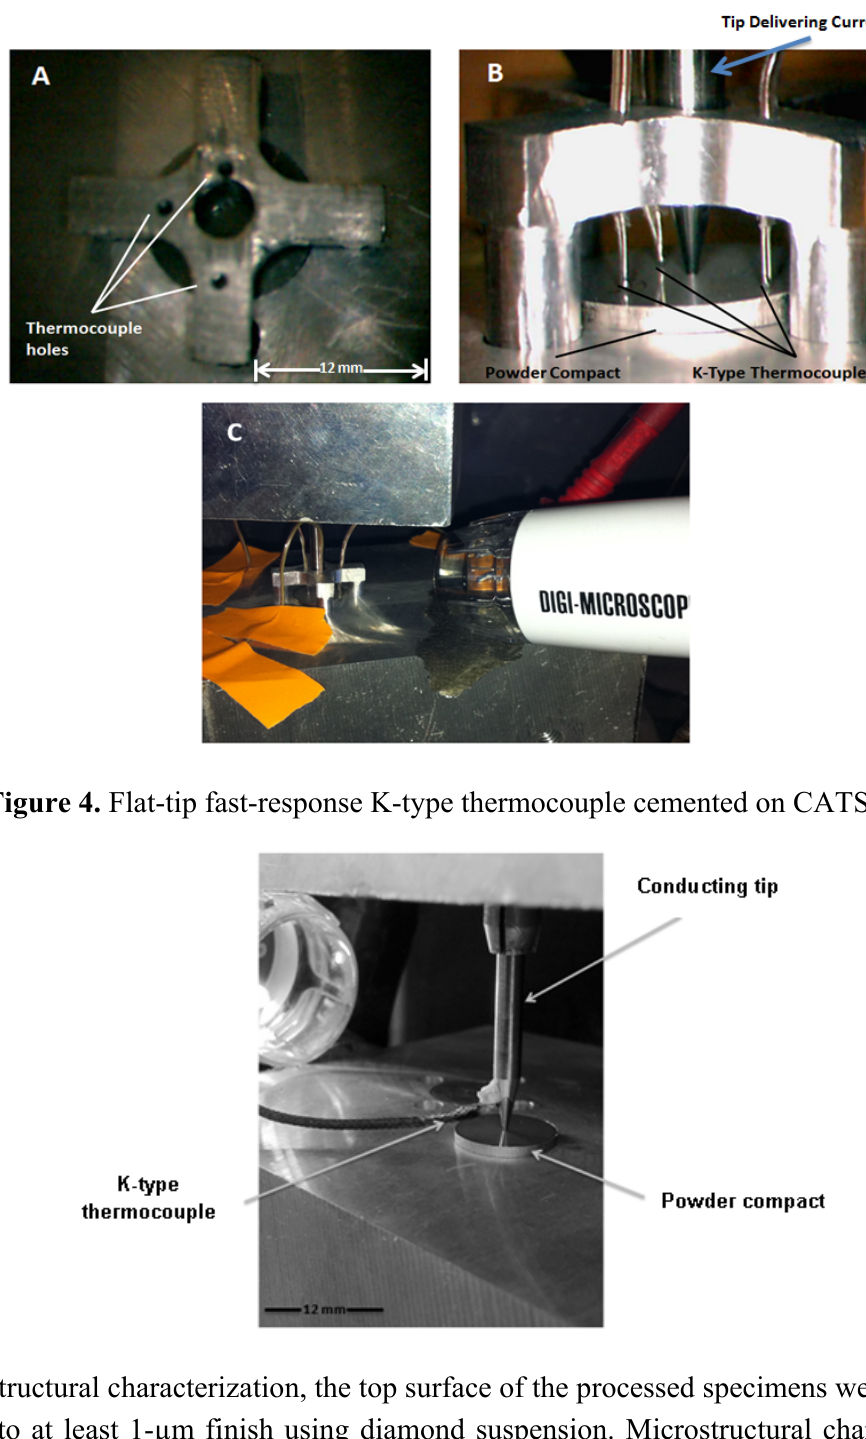
Figure 3. ( a ) Thermocouple holder with locating holes at different radial distances; ( b ) close-up photograph of tip-specimen-thermocouples configuration and ( c ) a photograph of the setup after all attachments are in place.